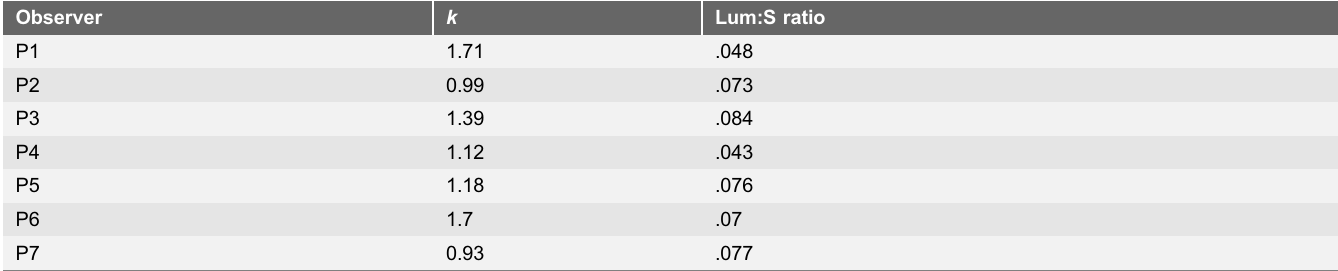
Table 1. Isoluminance measures for all